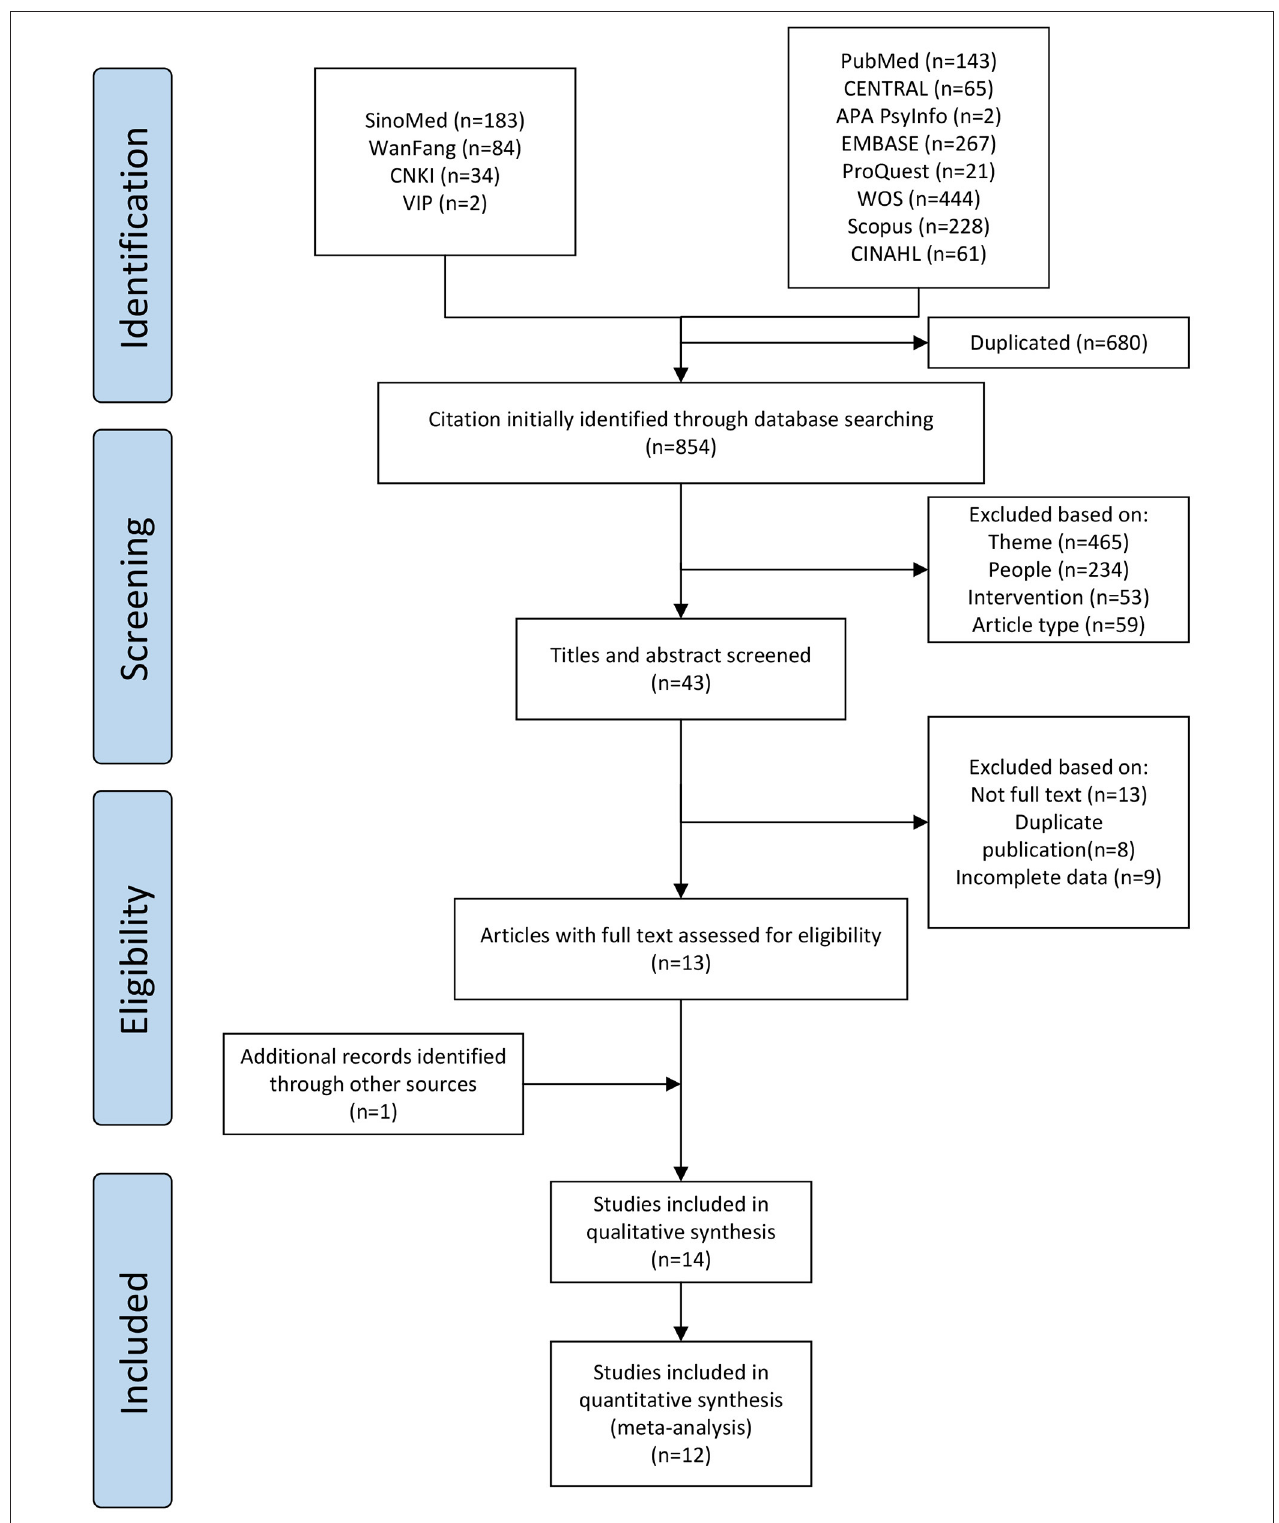
FIGURE 1 | PRISMA flowchart of study